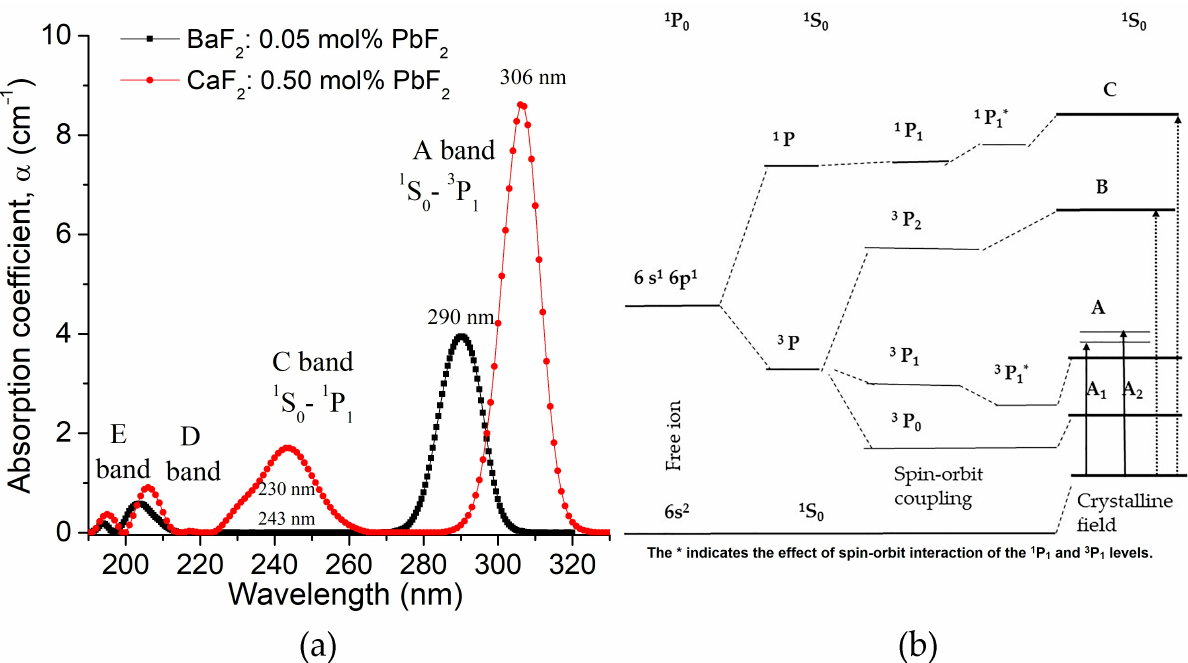
Figure 3. ( a ) Optical absorption spectra of BaF 2 : 0.05 mol% PbF 2 and CaF 2 : 0.5 mol% PbF 2 crystals; ( b ) energy level diagram of the Pb 2+ ions (the * indicates the effect of spin-orbit interaction of the 1 P 1 and 3 P 1 levels).